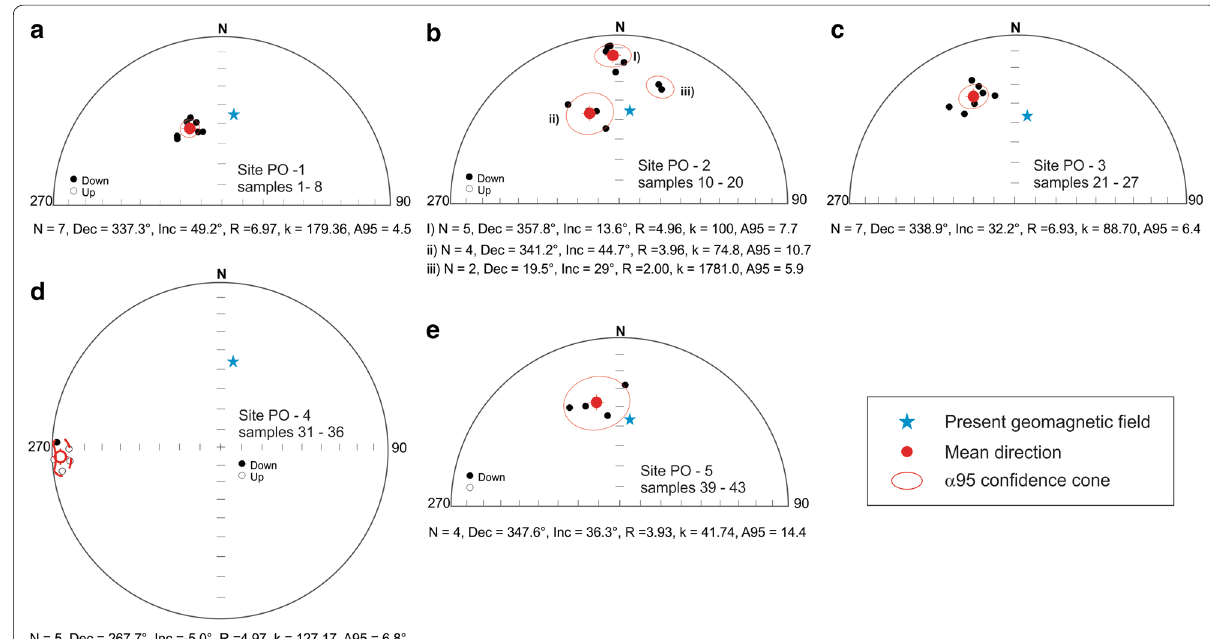
Fig. 14 Stereo plots showing the characteristic remanent magnetization (ChRM) directions for the studied pyroclastic density currents ( a and b ) and lava flows ( c – e ). Flow mean directions are shown by the red dots, together with their corresponding 95% confidence angles